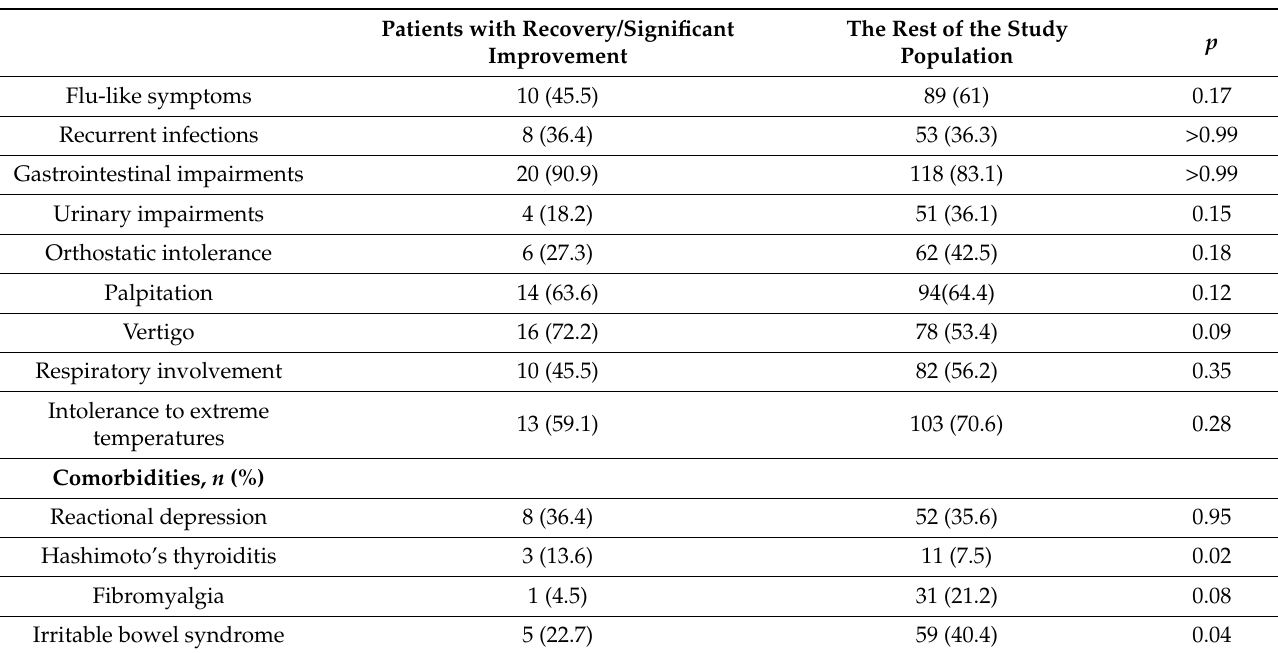
Table 1. Cont. Patients with Recovery/Significant